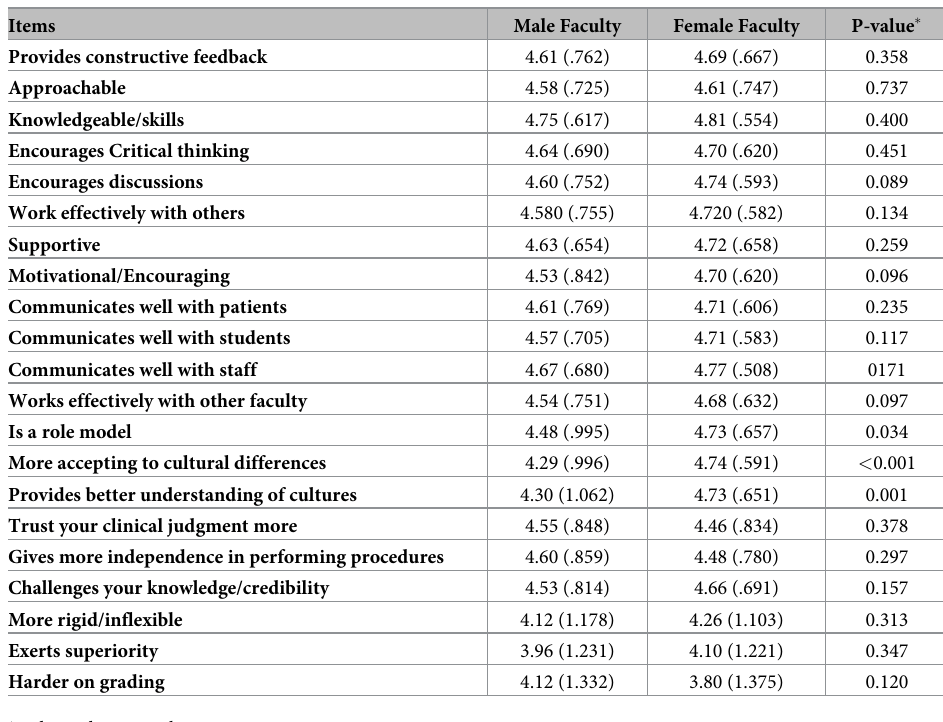
Table 3. Student’s mean (SD) perceptions scores for male and female